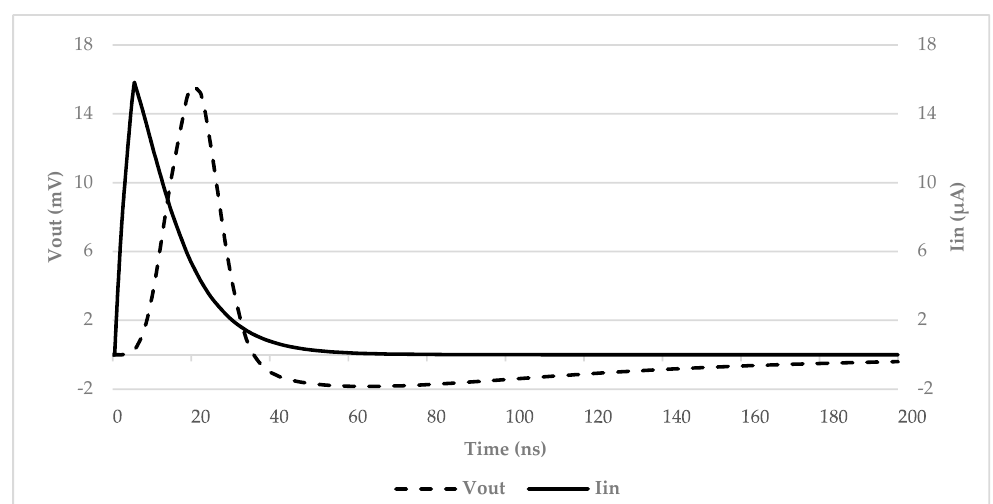
Figure 10. Simulation results on the prototype board: input current and output voltage of the discrete interface.